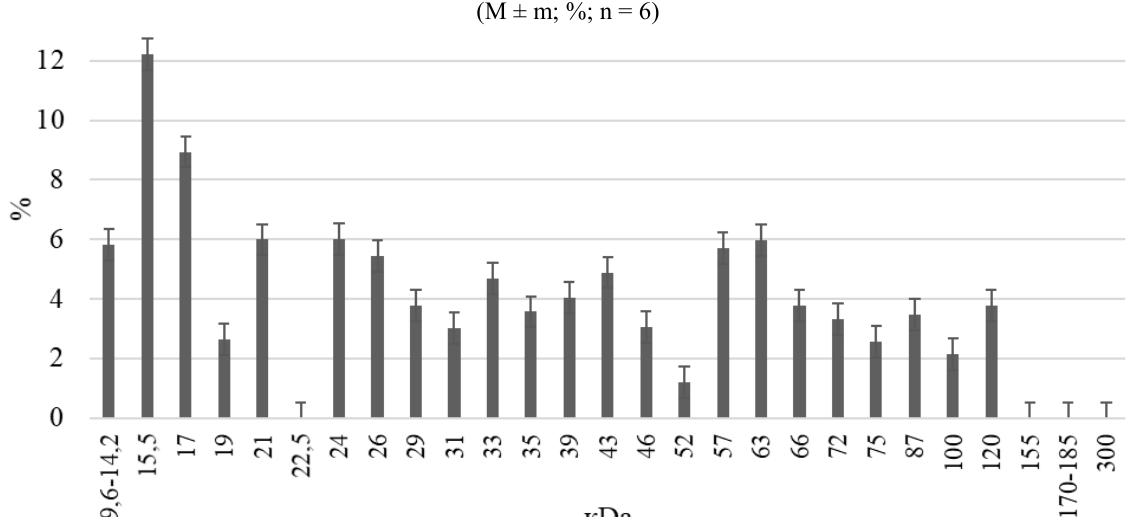
Fig. 4. Structural proteins of the basolateral membrane of the jejunum enterocytes of the two-month old cattle fetus (M ± m; %; n =